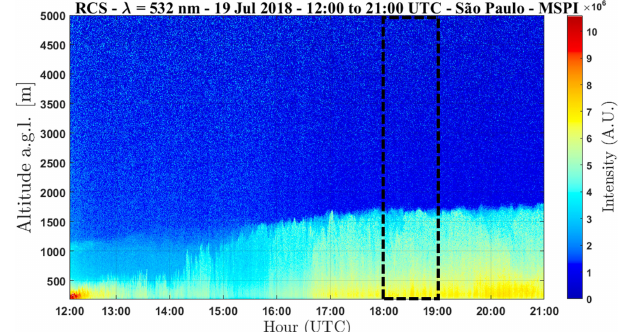
Figure 8. Time–height plot of RCS 532